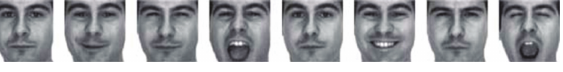
Figure 1: Sample face images from the AR database.